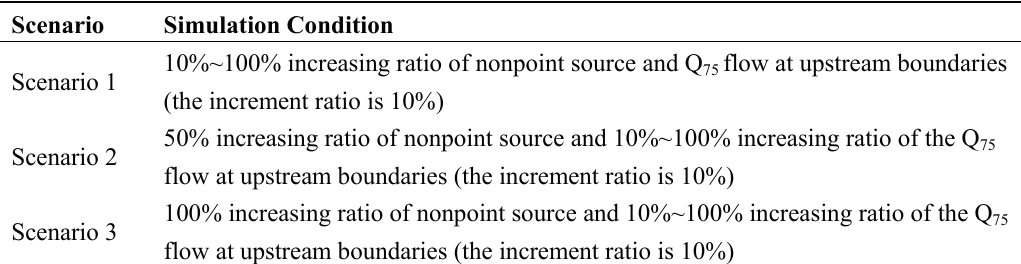
Table 9. Description of different scenarios for model